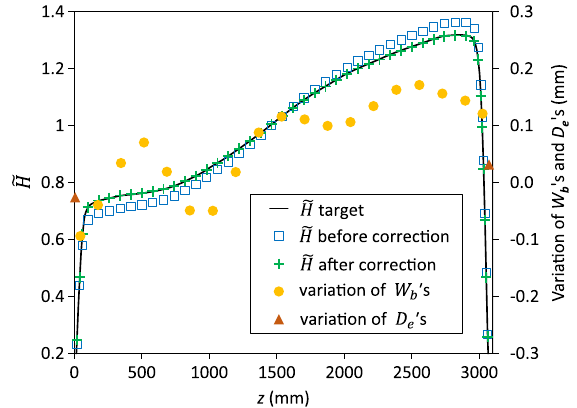
FIG. 6. Magnetic field profiles before and after the vane-tip modulation correction. The closed markers show the variations required for the correction.